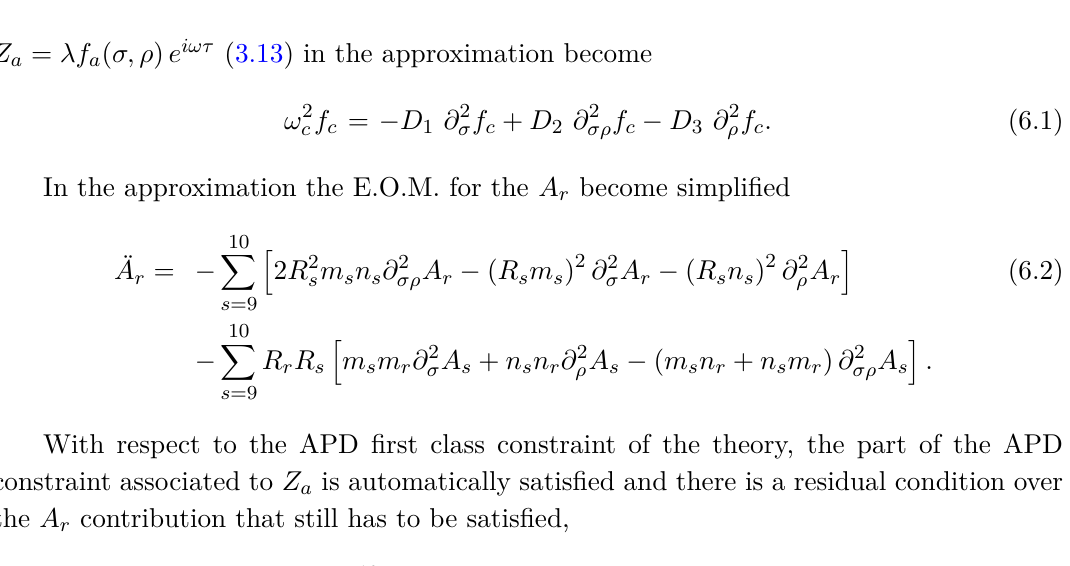
= λf ( σ, ρ ) e iωτ (3.13) in the approximation Z a a